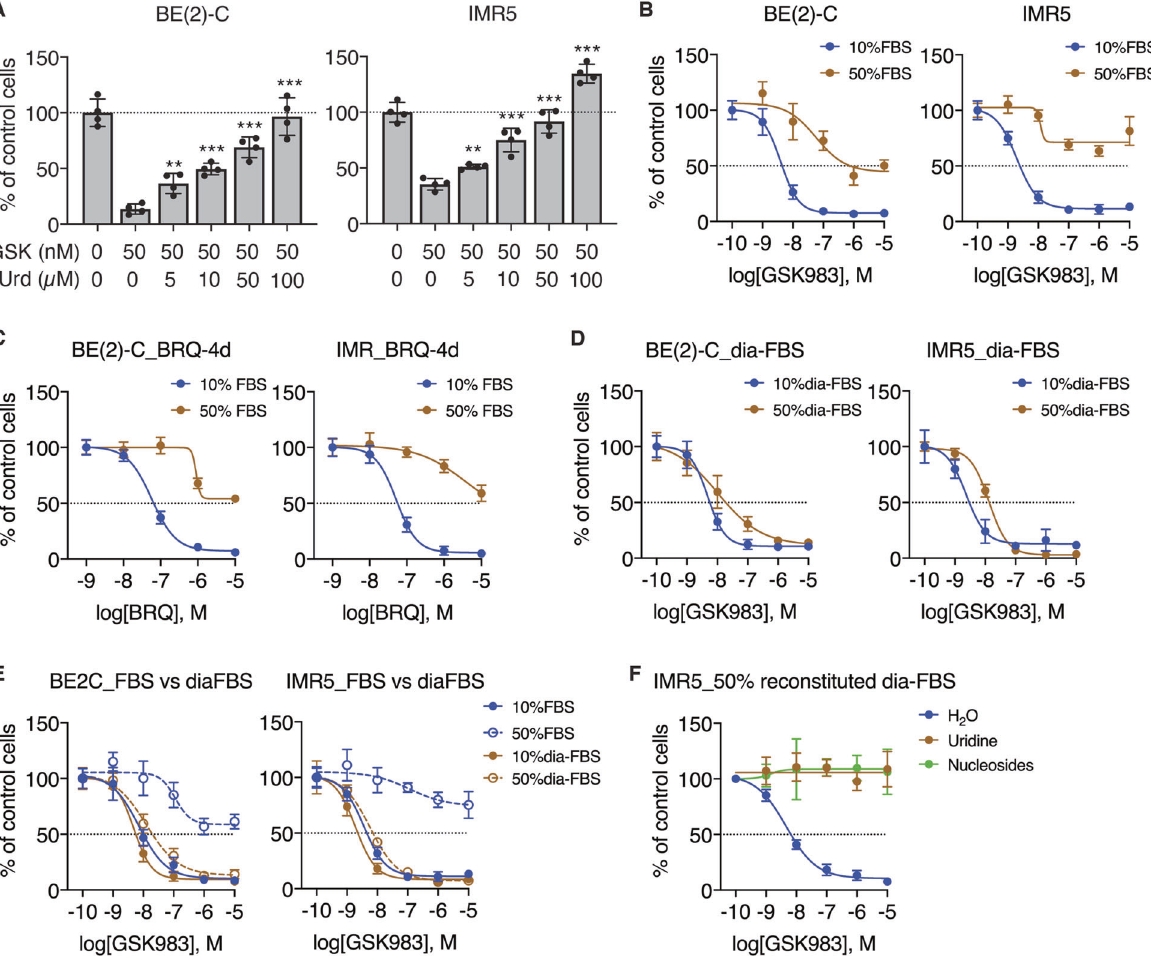
Fig. 5 Physiological concentrations of uridine antagonize the action of DHODH inhibitors. A Cell-growth assay of MYCN -ampli fi ed cell lines treated with GSK983 in the presence of increasing concentrations of supplemental uridine (Urd) in culture media containing 10% FBS for four days. Data are mean ± SD ( n = 4). P values were determined by two-tailed Student ’ s t -test between Urd-0 and individual Urd-containing groups. ** P < 0.01, *** P < 0.001. B, C Dose – response curves for GSK983 ( B ) and BRQ ( C ) in MYCN -ampli fi ed cell lines cultured in the presence of 10% or 50% FBS for four days. Data are mean ± SD ( n = 4). D Dose-response curves for GSK983 in MYCN -ampli fi ed cell lines cultured in the presence of 10% or 50% dialyzed FBS for 4 days. Data are mean ± SD ( n = 4). E Dose – response curves for GSK983 in MYCN -ampli fi ed cell lines cultured in the presence of 10% or 50% FBS before and after dialysis for four days. Data are mean ± SD ( n = 4). F Dose – response curves for GSK983 in IMR5 cells cultured in media containing 50% dialyzed FBS without or with supplemental uridine or nucleosides for four days. Data are mean ± SD ( n =